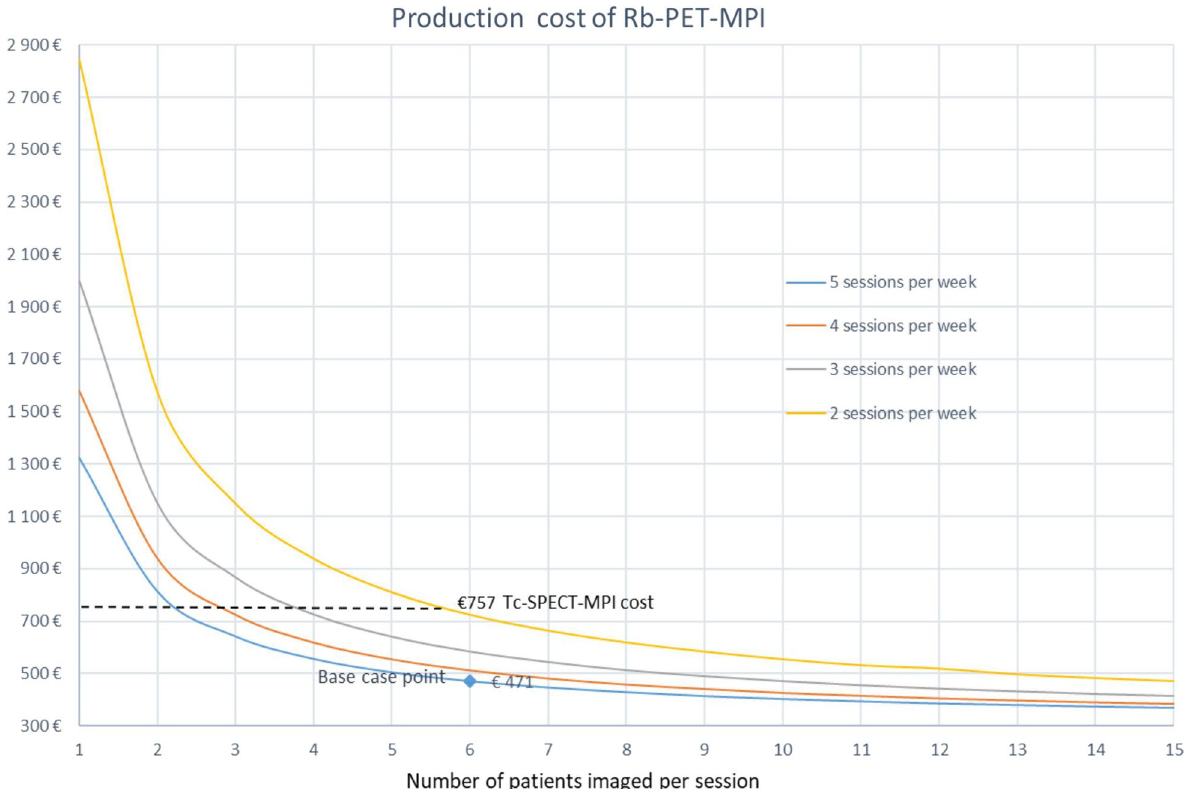
Fig. 2 Cost of Rb‑PET‑MPI procedure based on the number of patients imaged per